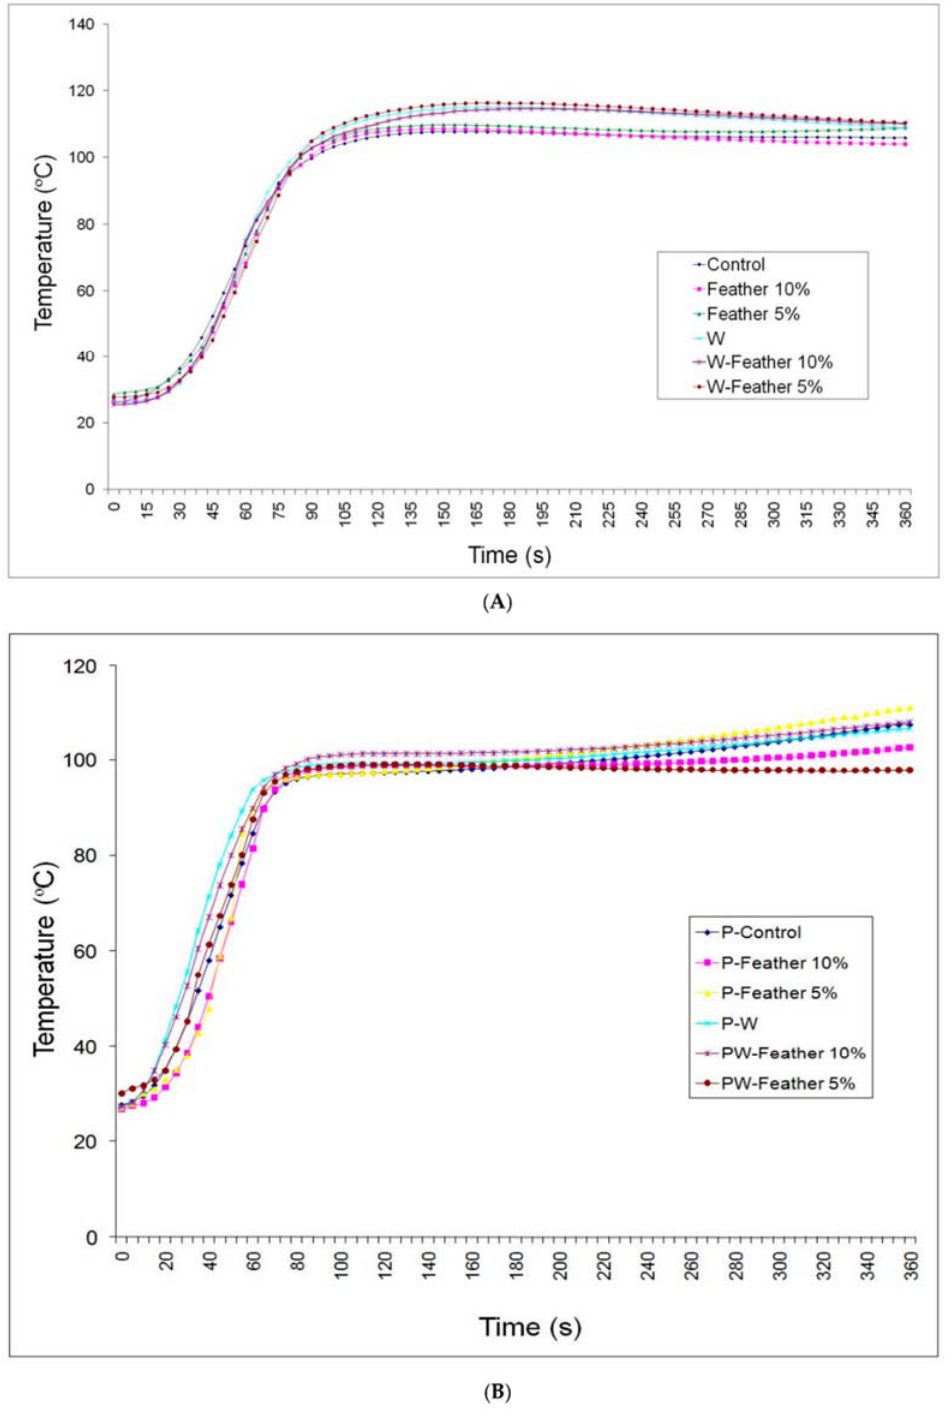
Figure 10. Temperature (Celsius) at the core section of the MDF ( A ), and the particleboard ( B ) at 5 ‐ s intervals (P = particleboard; MDF = medium ‐ density fiberboard; W = wollastonite; S = time intervals). Reprinted from [44] with permission of MDPI.